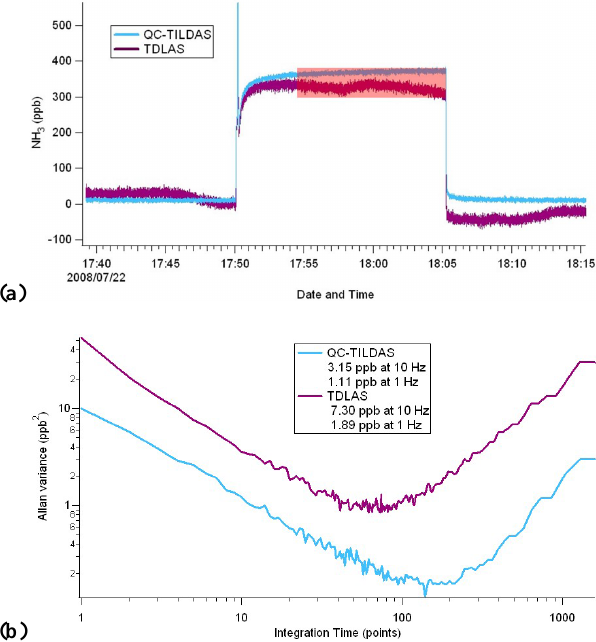
Fig. 4. (a) shows the time response at 10Hz of the QC-TILDAS and TDLAS to a step change from ambient to 350ppb NH 3 . In (b) , the Allan variance for both instruments is displayed for the ten minute period highlighted in red in panel